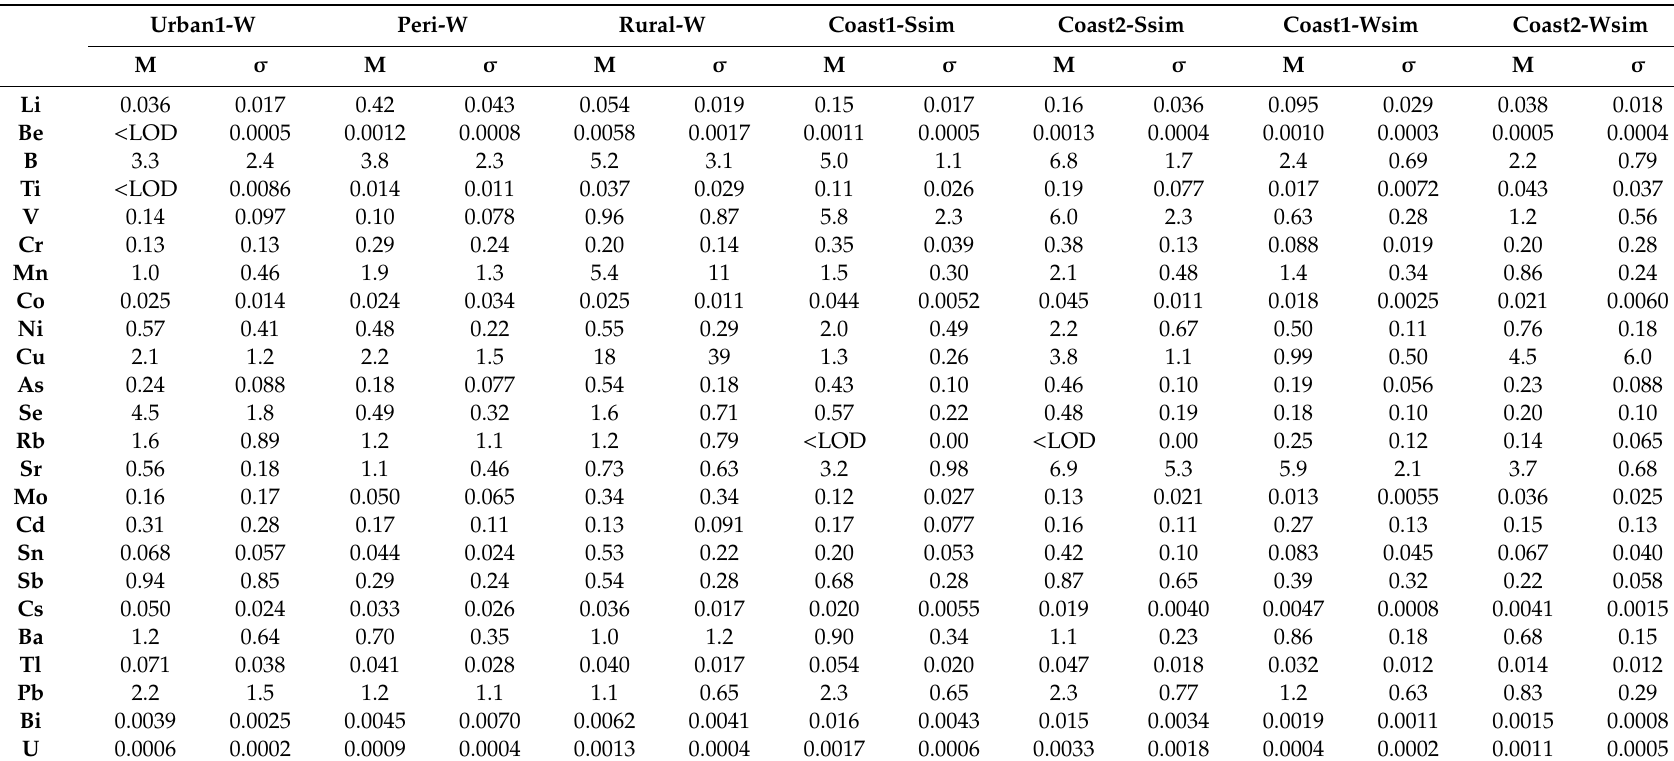
Table A1. Average mass concentrations (M) and standard deviations ( σ ) (in ng / m 3 ) of the extracted micro- and trace-components measured indoors. * < LOD indicates a value below the limit of